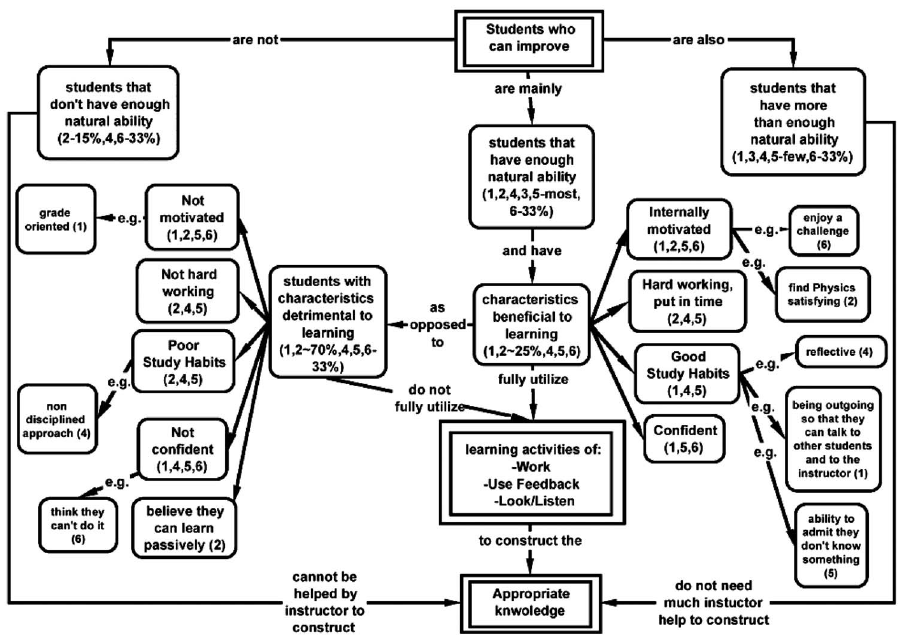
FIG. 4. Composite map for the principal category of “Students Who Can Improve.” The numbers in parentheses represent the iden- tification of the instructor who ex- pressed that